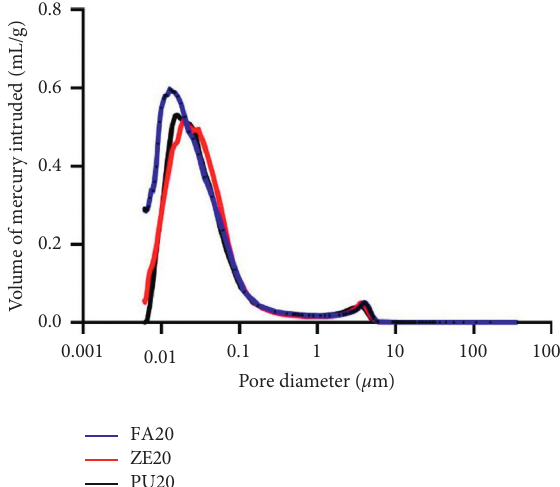
Figure 10: The volume of mercury intruded in natural pozzolans